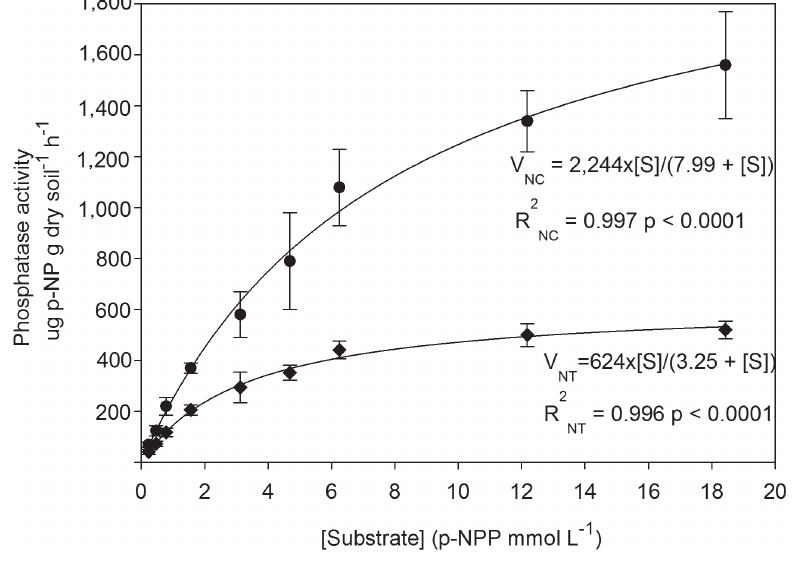
Figure 2 - Regression analysis of soil phosphatase activity using the Michaelis-Menten equation in the native Cerrado (NC) and no-tillage (NT). Where, V phosphatase activity in the native Cerrado (Circle) and V activity in no-tillage (Diamond) as a function of substrate (S) concentration. Values of determination coefficient (R 2 ) and significant level of each equation (p<0.001) are also